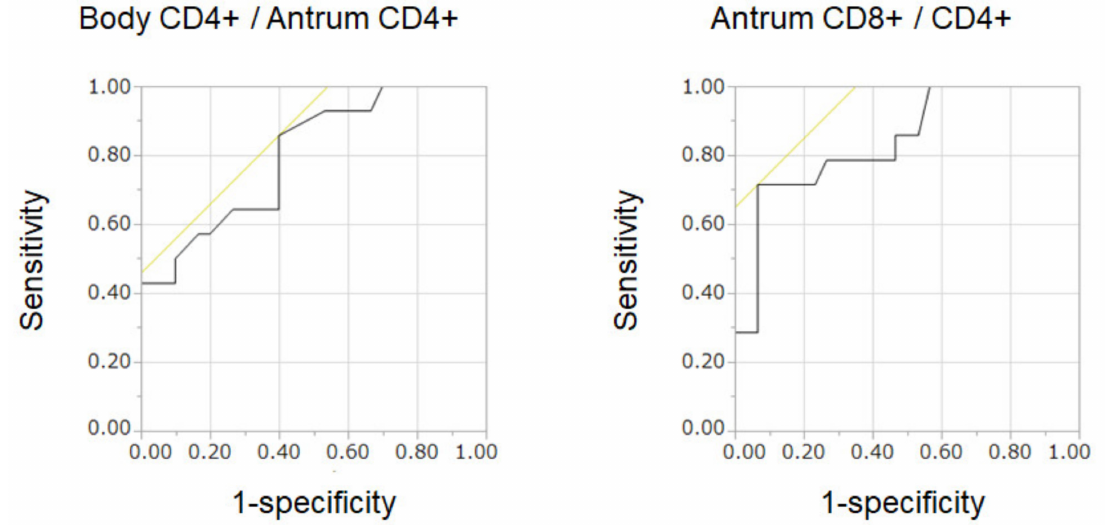
Figure 3. ROC curves: the area under the ROC curve of body CD4 + /antrum CD4 + was 0.799, and that of antrum CD8 + /CD4 + was